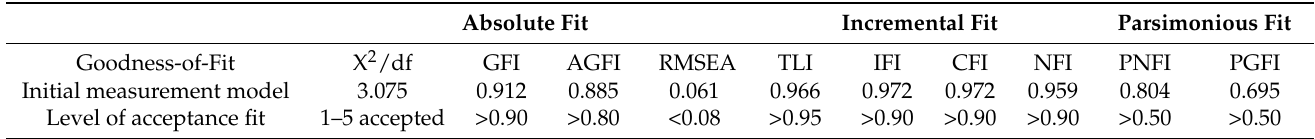
Table 6. Goodness-of-fit of the initial measurement model.